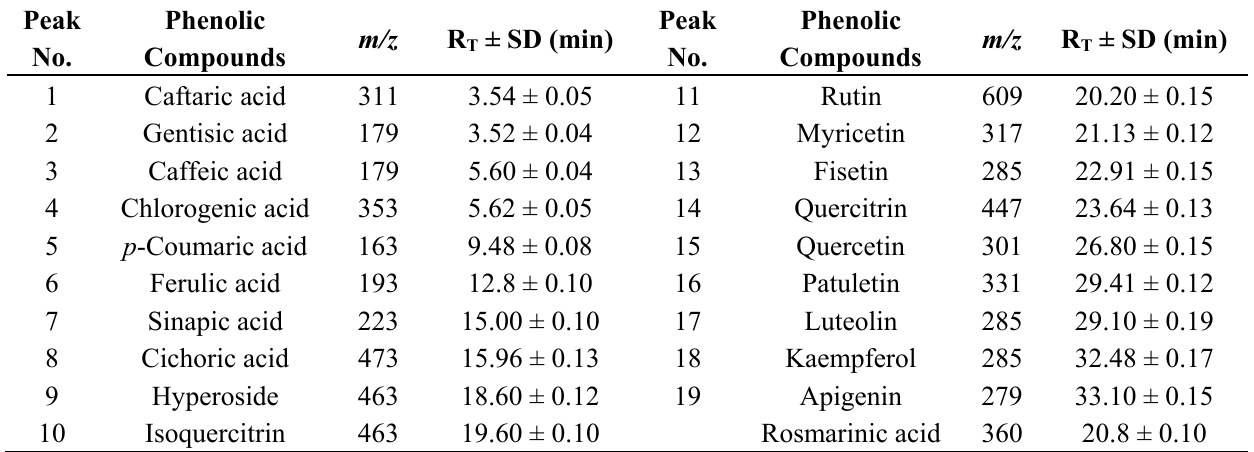
) of polyphenolic compounds T